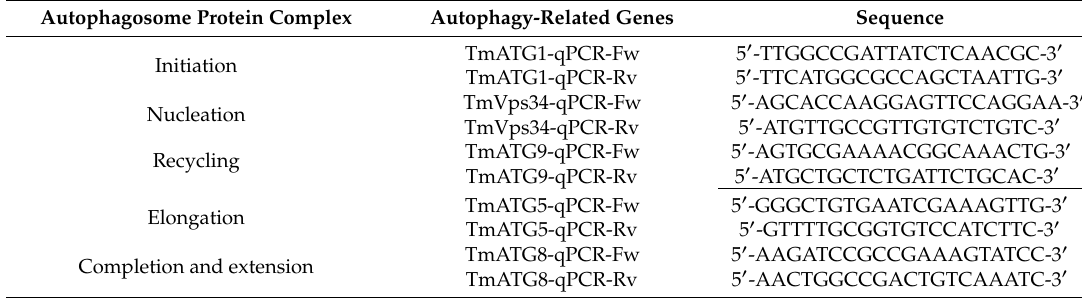
Table 2. Sequences of the primers used in this study.